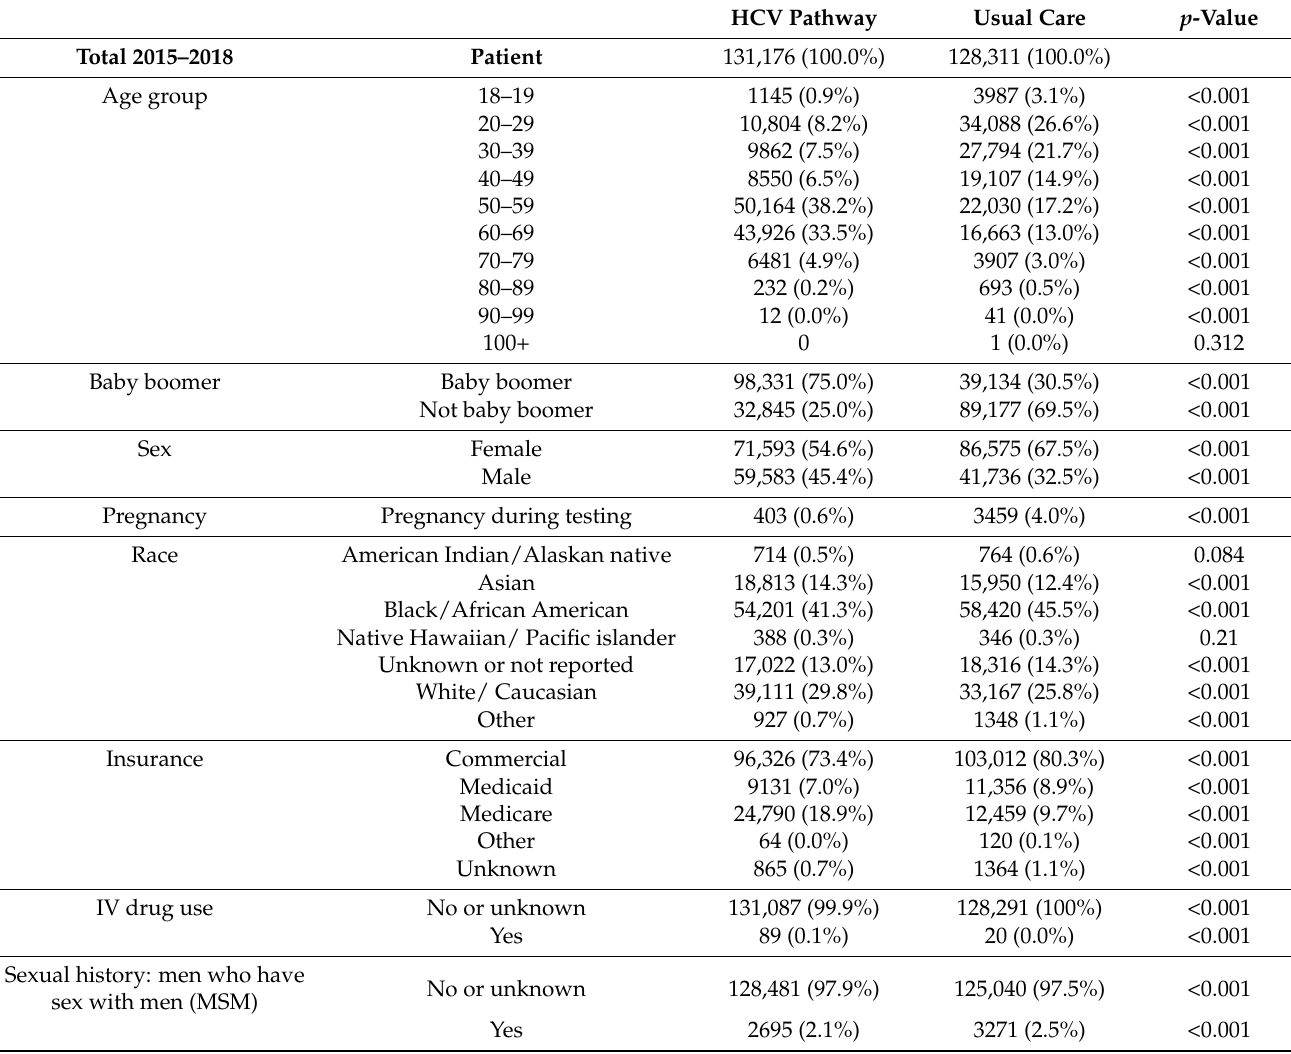
Table 1. Demographics of individuals tested for HCV through the HCV pathway vs. usual care. HCV Pathway Usual Care p